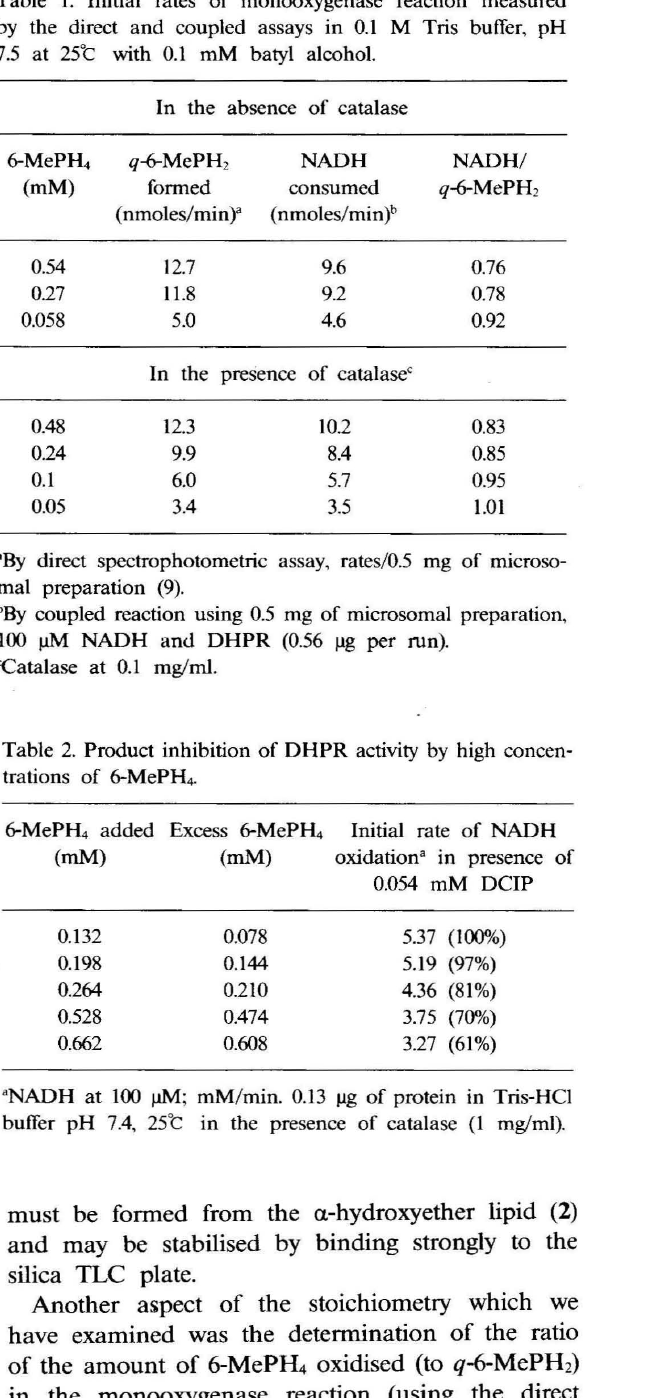
Table 1. Initial rates of monooxygenase reaction measured by the direct and coupled assays in 0.1 M Tris butTer, pH